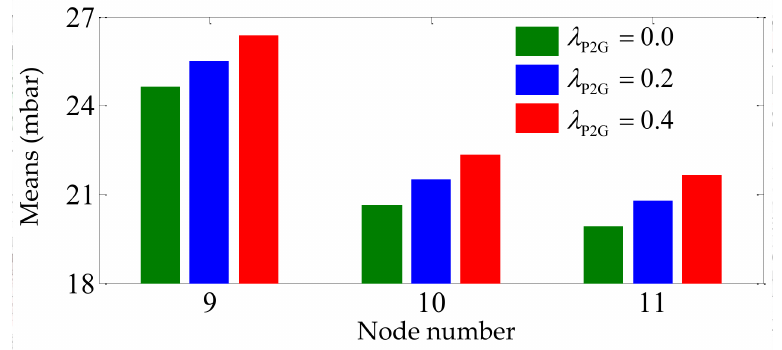
Figure 10. Mean values of pressures of nodes 9, 10 and 11.